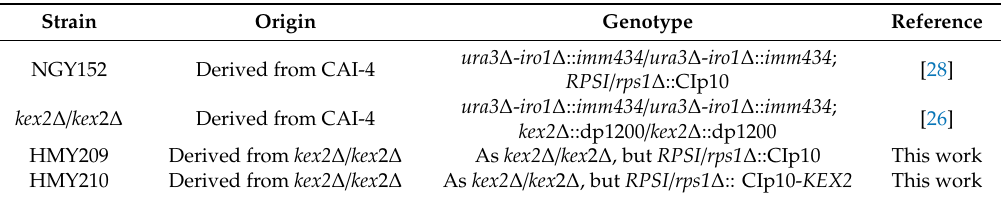
Table 1. Candida albicans strains used in this